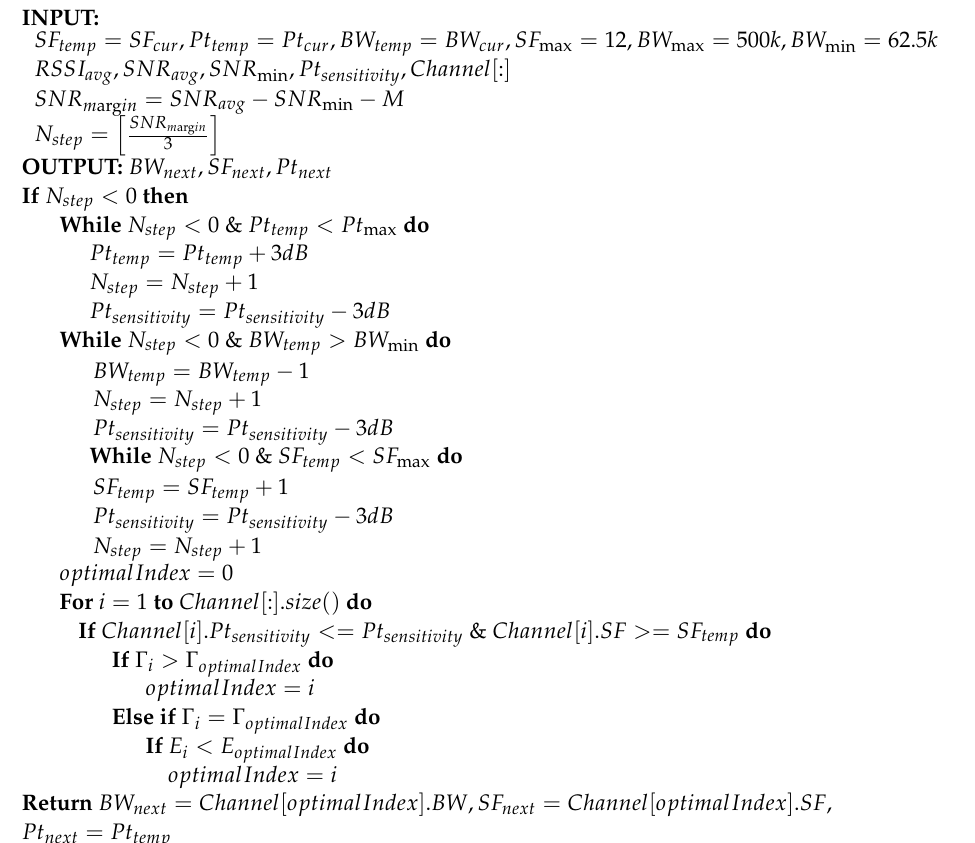
Algorithm 2: Bad Link Quality Link Parameter Adaptation Algorithm